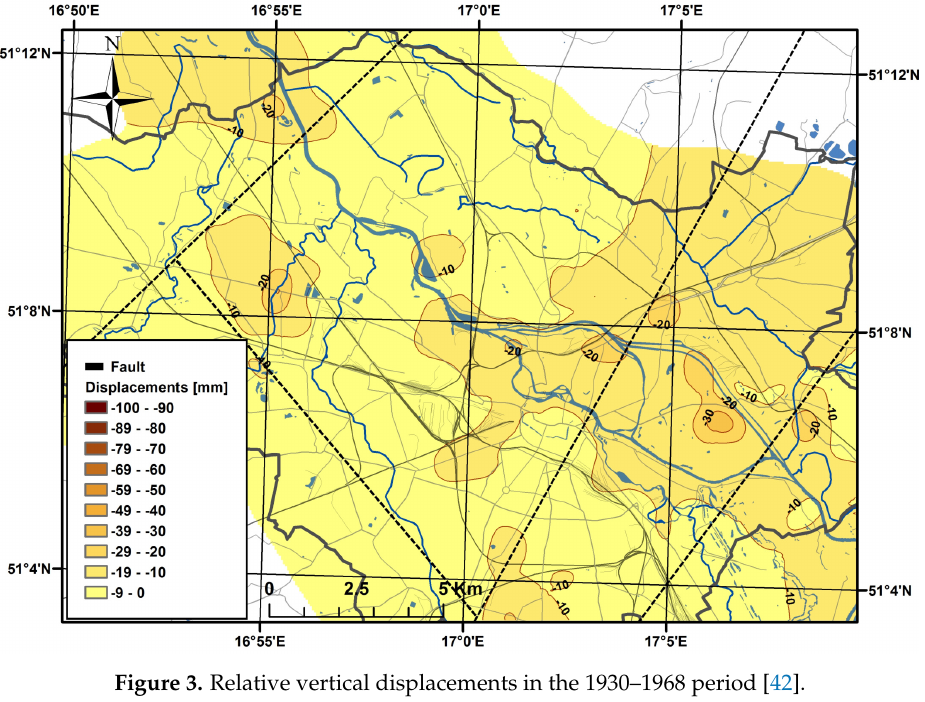
Figure 3. Relative vertical displacements in the 1930–1968 period [42].